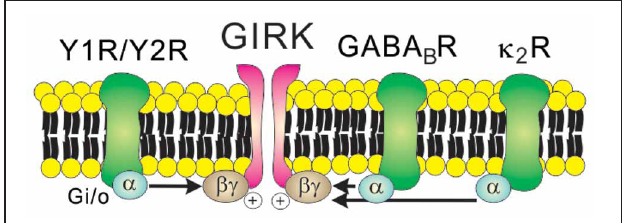
FIGURE 4 | Receptor-mediated regulation of TRPC channels. 5-HT 2C receptors (Gq protein-coupled receptors) and leptin receptors (type 1 cytokine receptors) open TRPC channels via the PLC signaling pathway. Note that leptin receptors activate PI3K prior to PLC